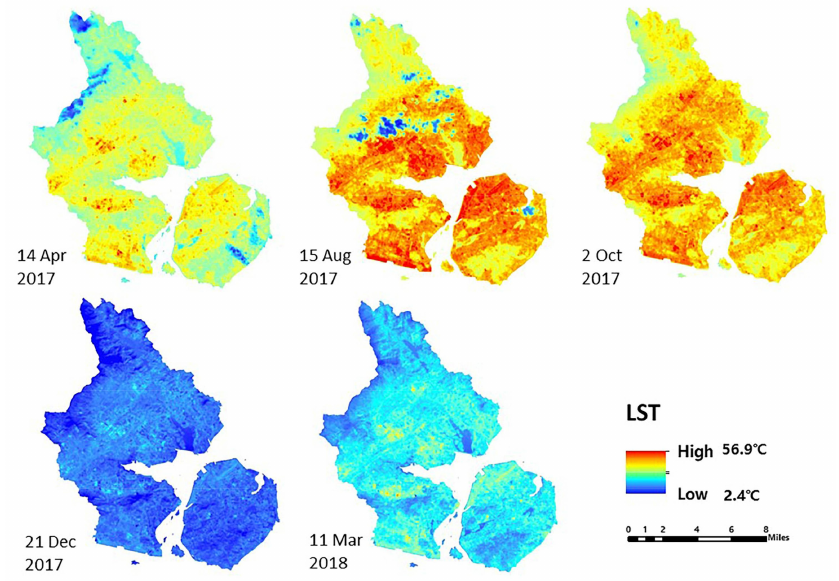
Figure 7. Land surface temperature (LST) images in five different